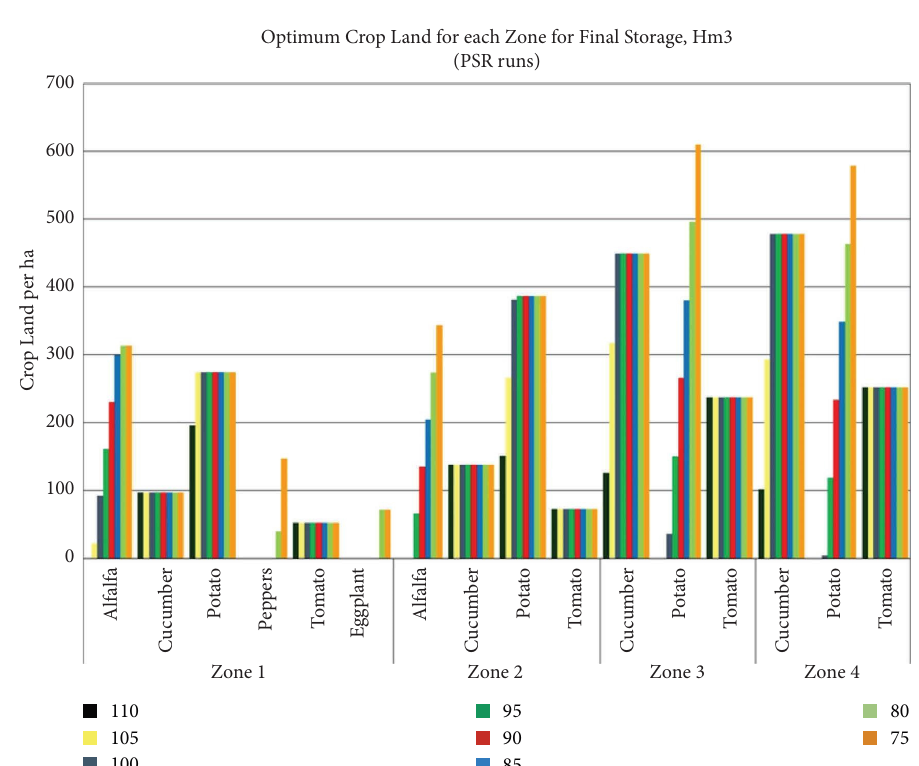
Figure 4: Optimum crop land for each zone using PSR